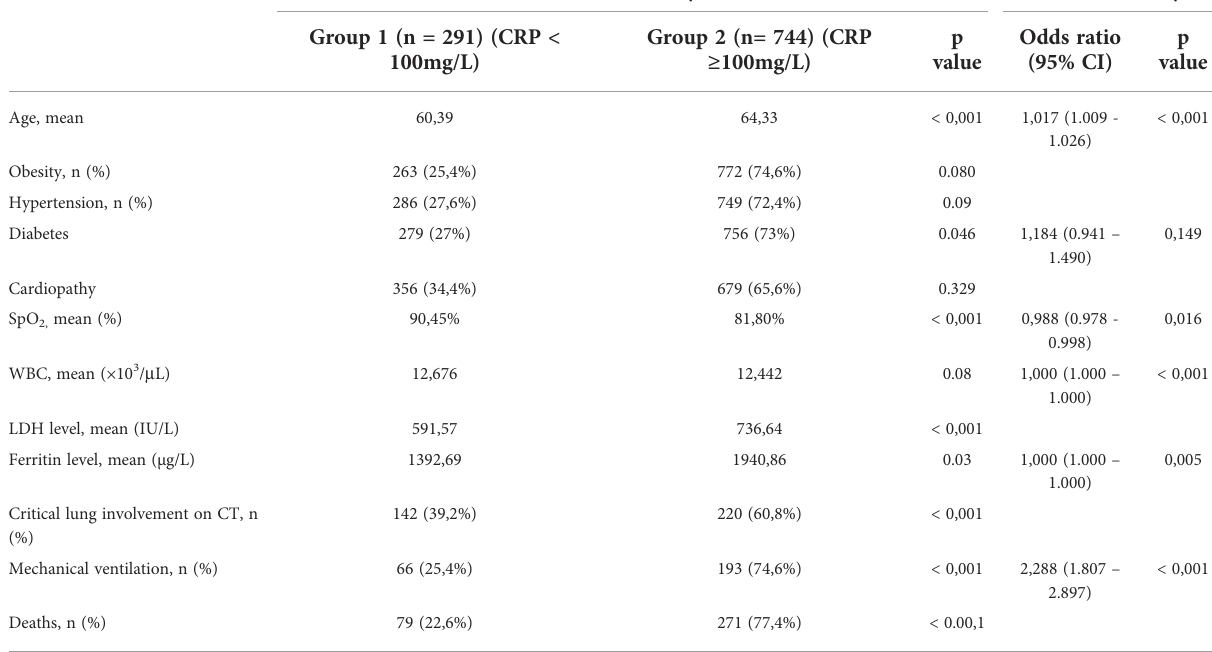
TABLE 2 Univariate and multivariate analyses of the logistic regression model.